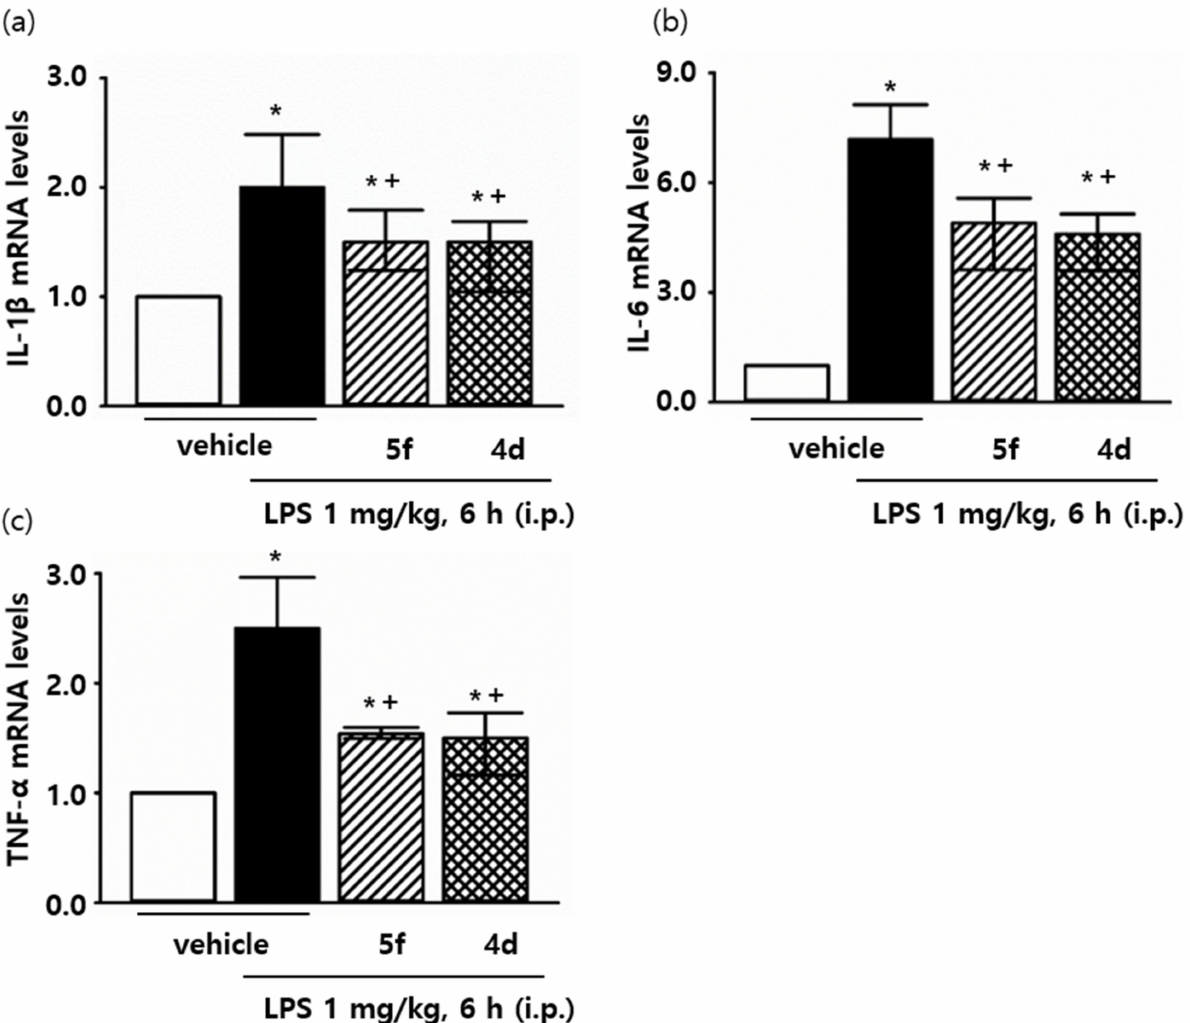
Figure 3. mRNA expression levels of inflammatory cytokines after treatment of compounds 5f and 4d . ( a ) mRNA expression level of IL-1 β , ( b ) mRNA expression level of IL-6, ( c ) mRNA expression level of TNF- α . * p < 0.05 compared with the group treated with the PBS (vehicle). + p < 0.05 compared with the group treated with the LPS. Data are presented as the mean ±